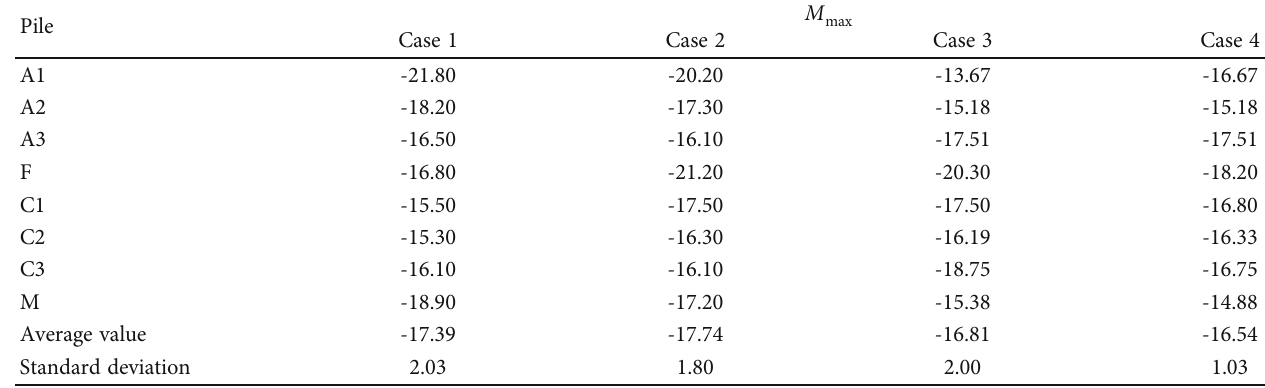
Table 2: Discrete calculation results of extreme values of bending moment ( p = 20 kPa